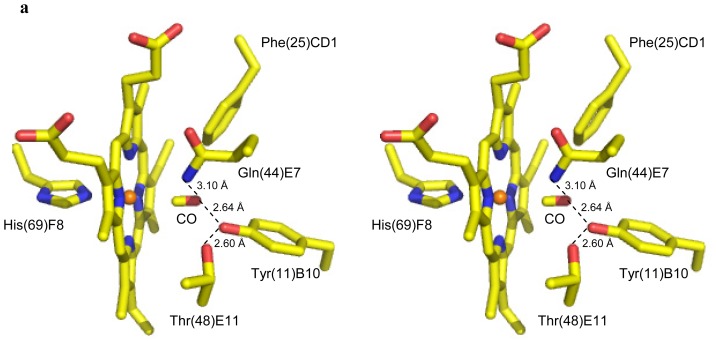
Ligand stabilization at the heme distal site of CerHb. Stereo view of the distal site region in (a) CerHb-CO (yellow) and (b) CerHb-O2 (cyan). The heme iron atom is shown in orange. Hydrogen bonds are drawn as dashed lines.